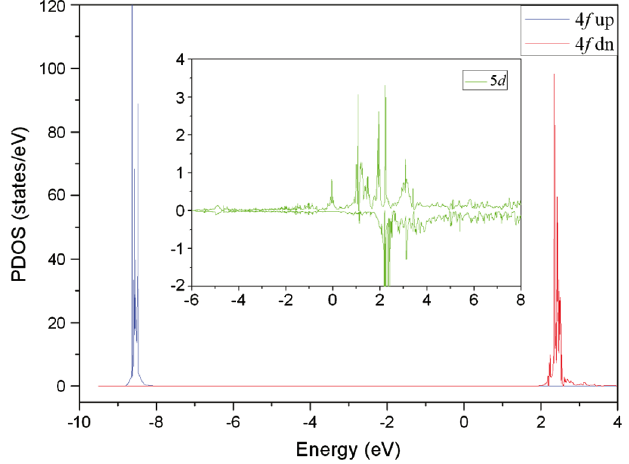
FIG. 3. Partial density of states of a single Gd on the CuN